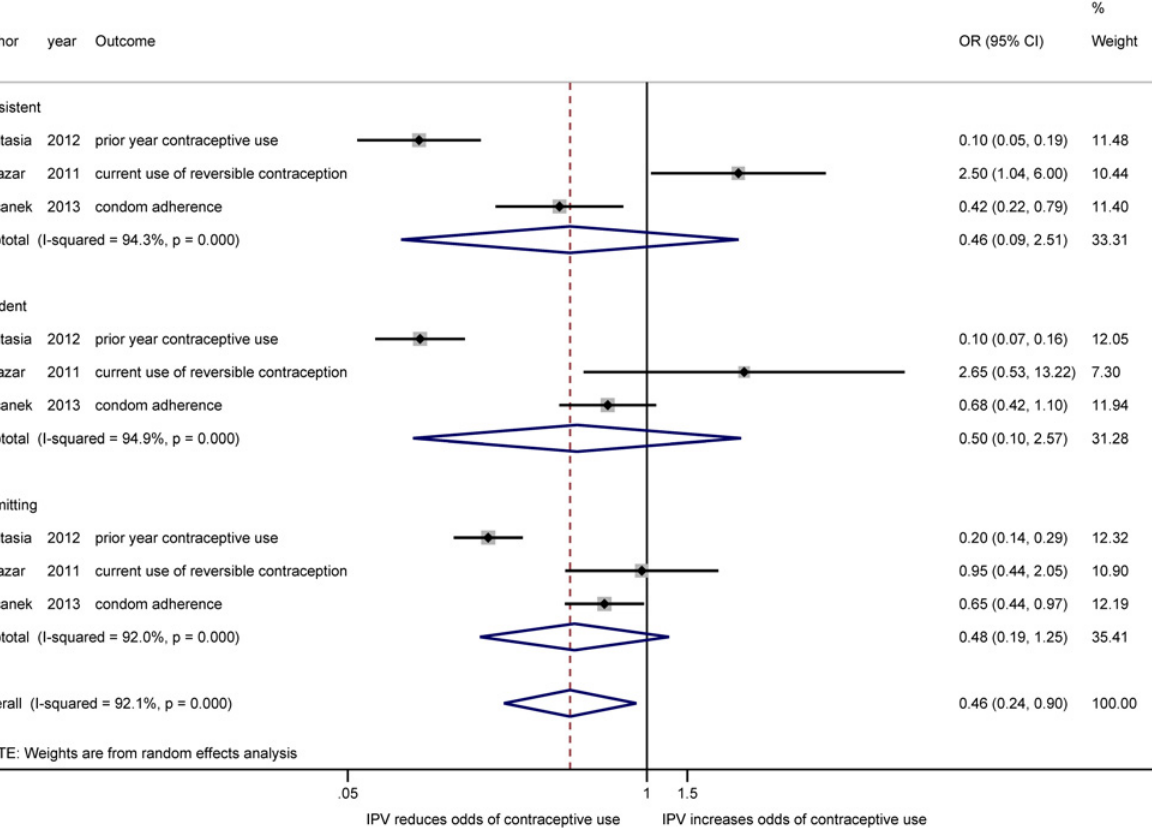
Fig 5. Meta-analysis of the association between IPV and contraceptive use, by duration of exposure. Estimated effect measures from the Fantasia and Kacanek studies have been inverted to present estimates of contraceptive use rather than non-use.